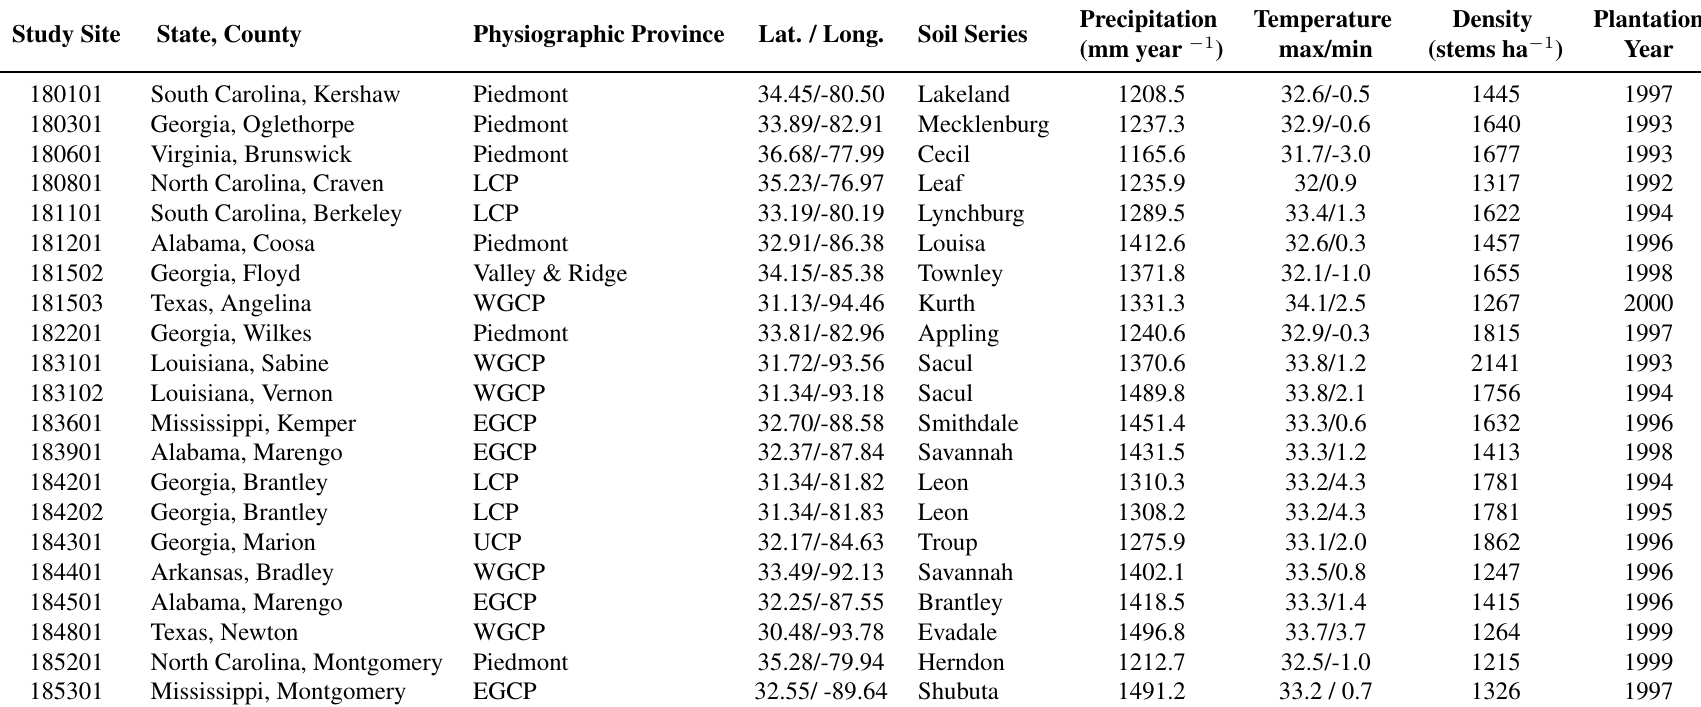
Table 1. Location (State, County), physiographic regions, latitude / longitude (decimal degrees), soil series, average annual precipitation, average maximum and minimum temperature ( ◦ C), planting density (stems ha − 1 ), and plantation year for study sites used to determine relationship between site index and FR in